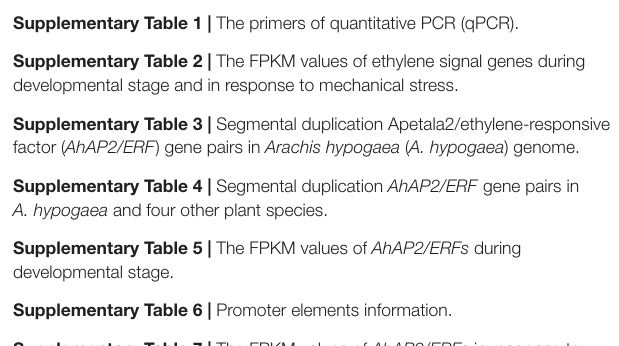
Supplementary Figure 4 | Alternative splice (AS) analysis of Apetala2/ethylene-responsive factor ( AP2/ERF ) genes in A. hypogaea . ES, exon skip; AP, alternate promoter; AT, alternate terminator; RI, retained intron. The red inverted triangle indicated the difference of AS. Supplementary Figure 5 | Protein sequence alignment and express pattern of AhPiezo. Supplementary Table 1 | The primers of quantitative PCR (qPCR).